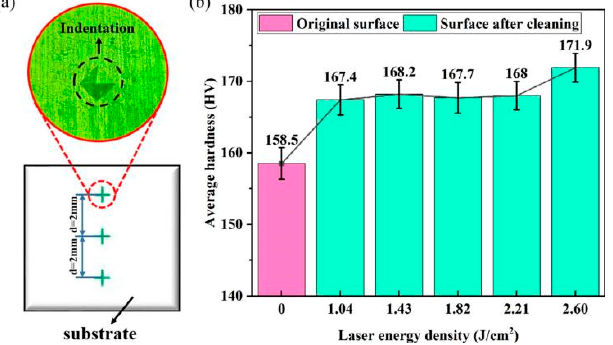
Figure 9. ( a ) Microhardness indentation and test point position; ( b ) change in microhardness values before and after laser cleaning [35].